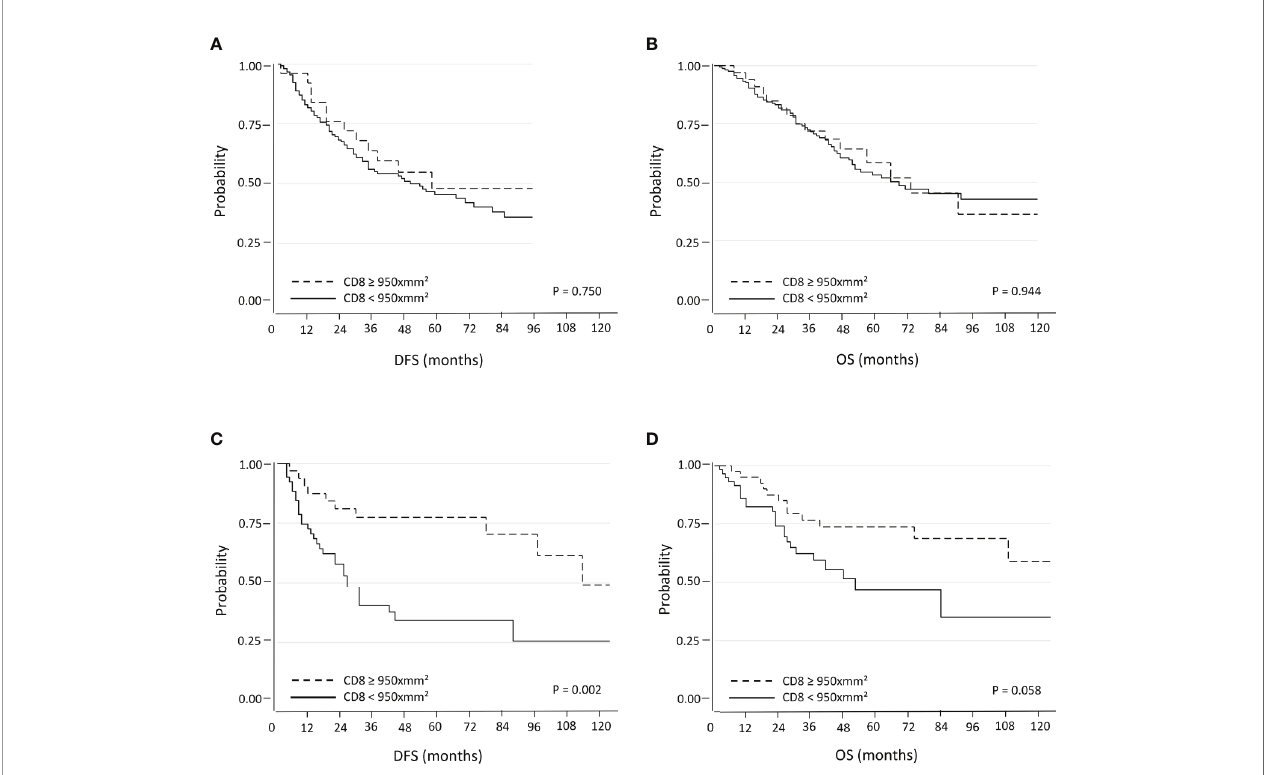
FIGURE 3 | Kaplan-Meier curves for DFS andOS based onCD8 + TILs using the 75 th percentile as the threshold in PD-L1 negative (A, B) and PD-L1 positive (C, D)